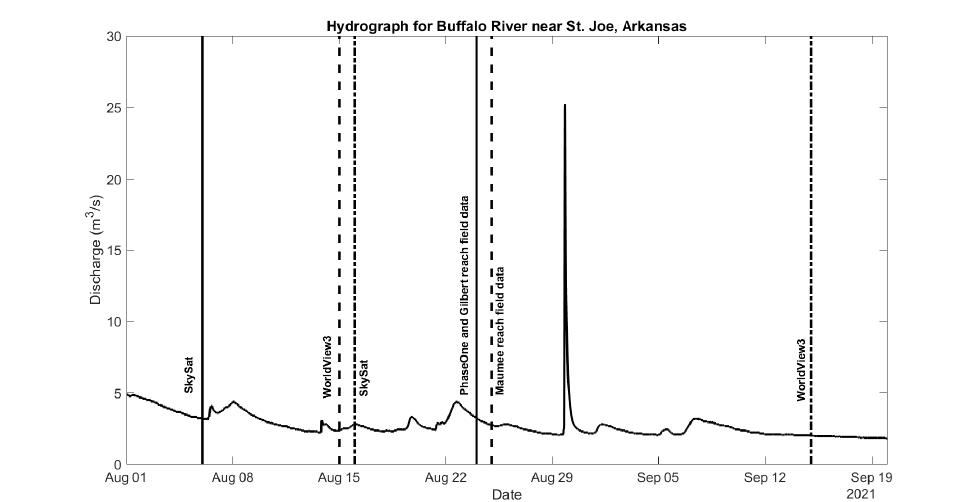
Figure 3. Hydrograph for the USGS streamgage (#07056000) on the Buffalo River near St. Joe, Arkansas, showing variations in discharge during the study. The dates of image acquisition and field data collection are indicated by the labeled vertical